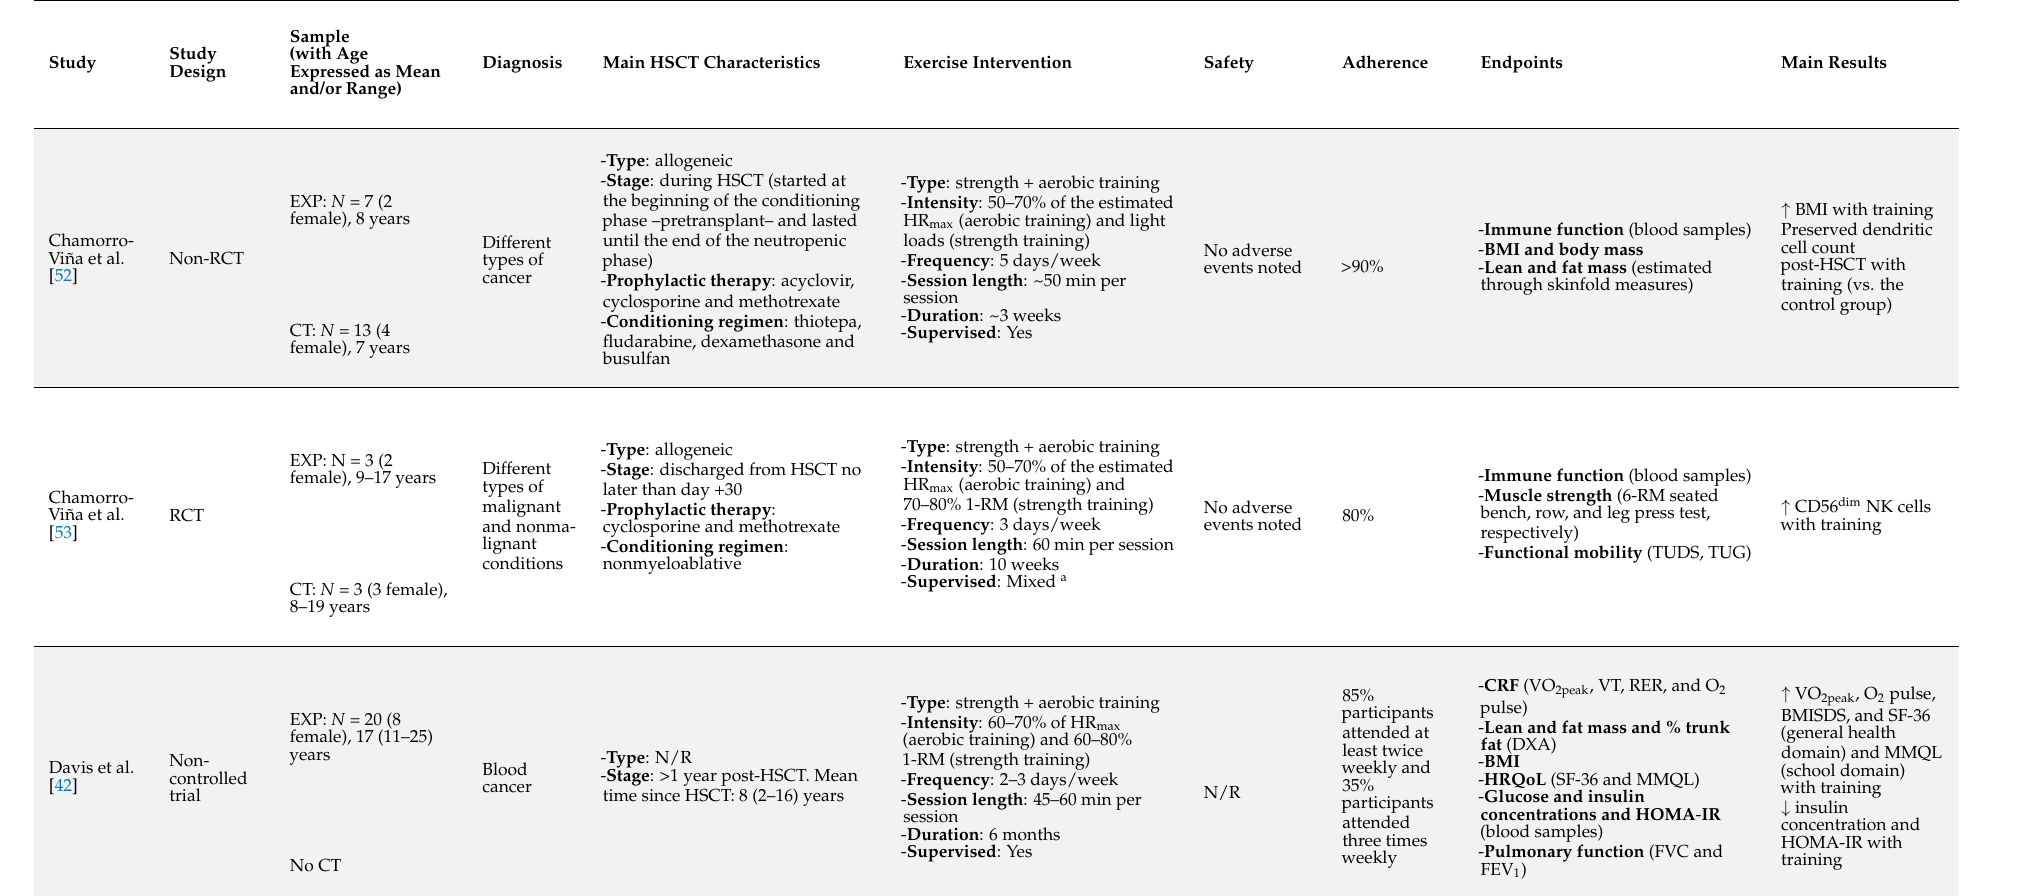
Table 2. Examples of relevant studies on the effects of exercise intervention during/after childhood hematopoietic stem cell transplantation